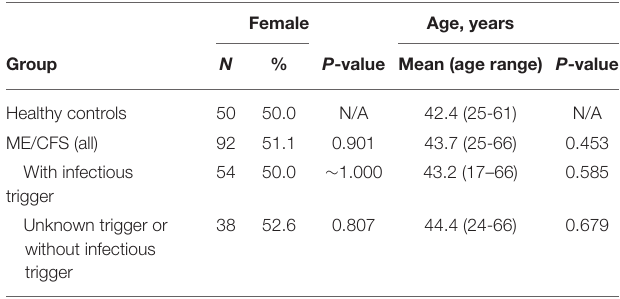
TABLE 1 | Basic characteristics of ME/CFS patients and healthy controls, where p -values refer to the comparison between ME/CFS groups and healthy